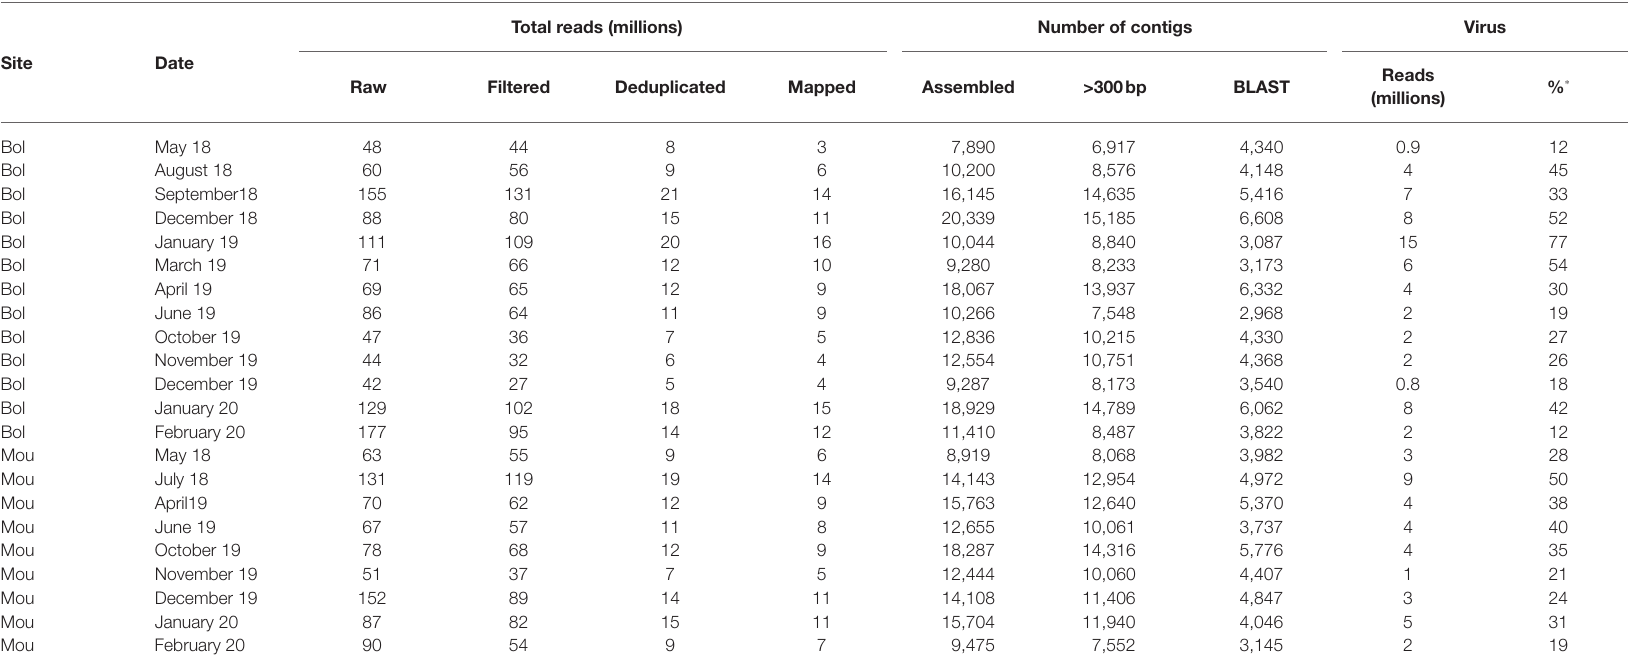
TABLE 2 | Summary of read numbers and contigs at different steps of the pipeline per